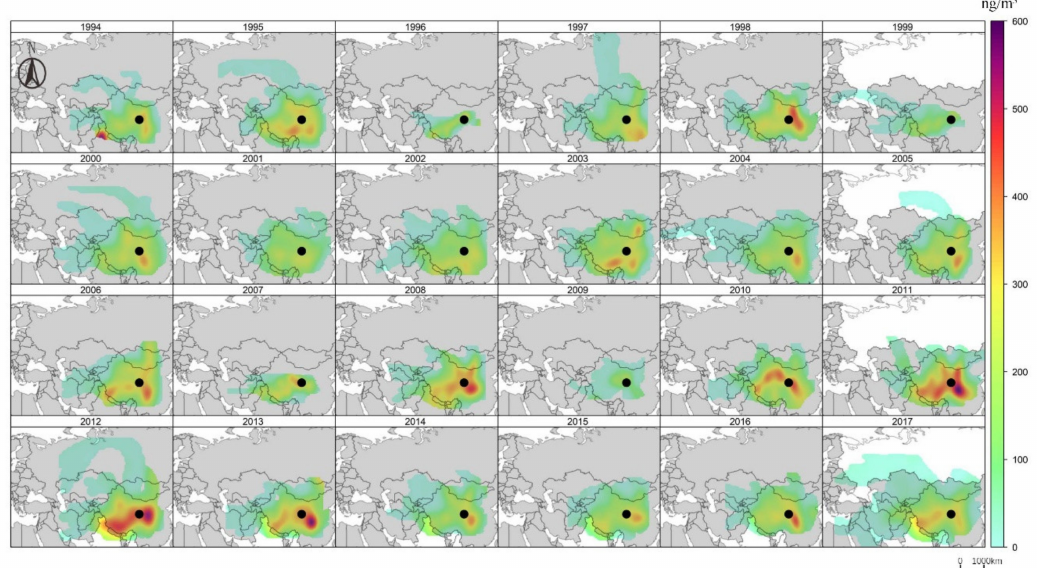
Figure 8. The analysis of potential sources using the CWT approach of BC in